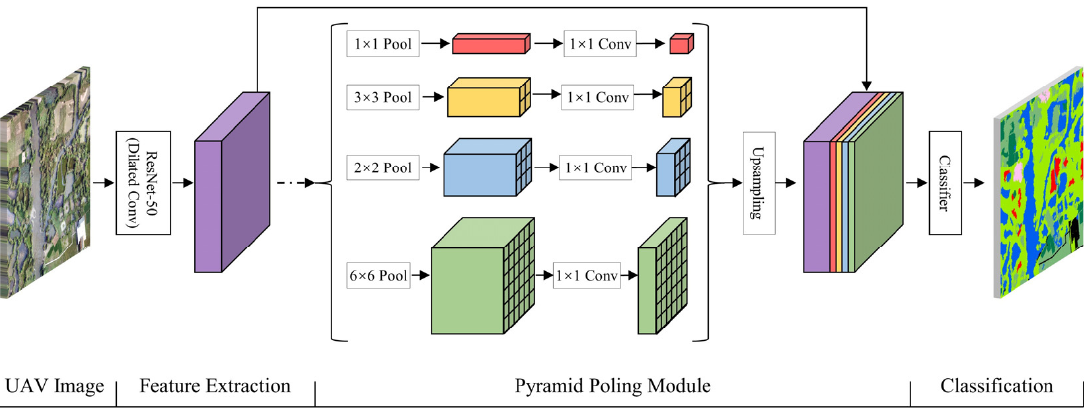
Figure 5. Structure of the PSPNet algorithm.